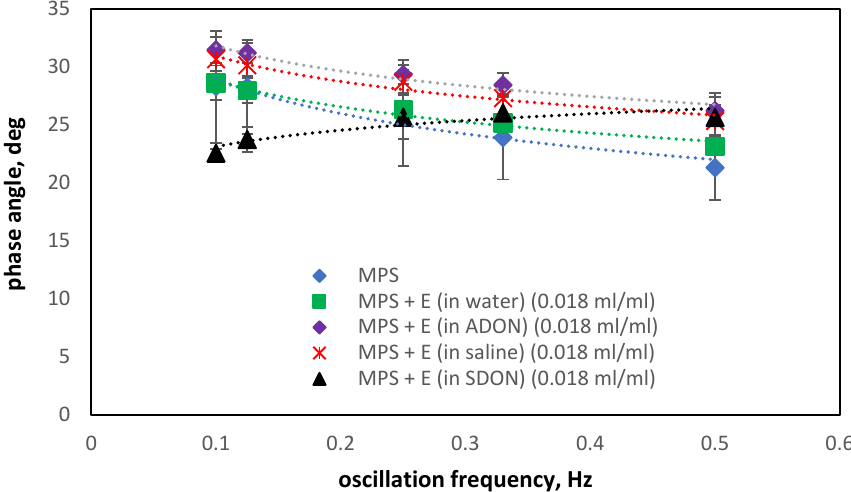
Figure 10. Changes of the phase angle in the oscillation of air/liquid interface with MPS (concentra- tion of 2.5 mg/mL) in presence of ADON or SDON and ectoine (E).